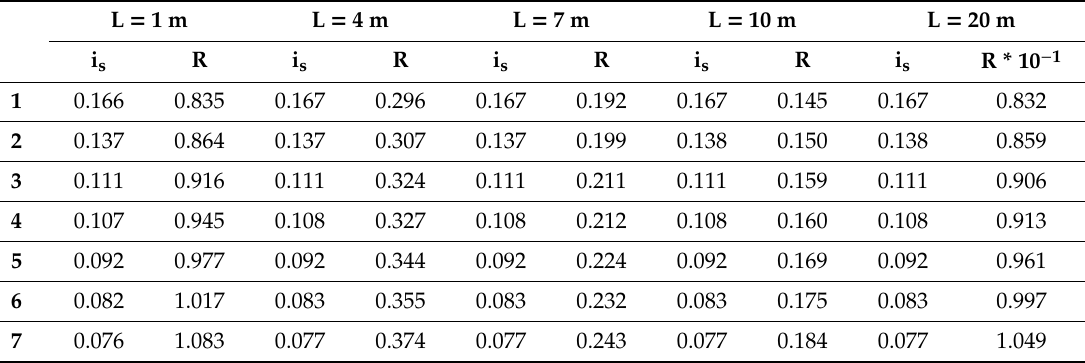
Table 1. Grounding resistance R in Ohms for all types of electrodes in Figure 1 as a function of the index i s and the electrode length L, when the current is I = 1A and the soil resistivity is ρ = 1 Ω m. The segmentation is stated at N = 20 segments /